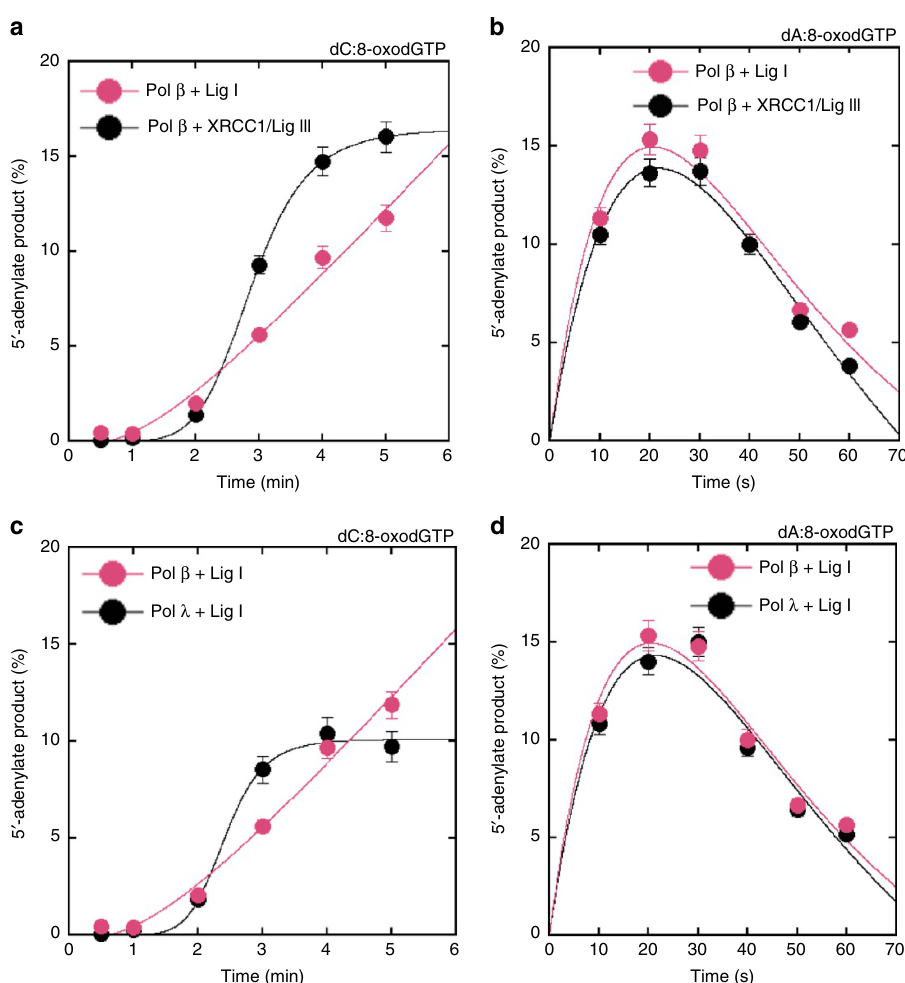
Figure 7 | Effect of XRCC1/Lig III and pol k on ligation failure. Plots show time-dependent changes in the products of 5’-adenylation for Lig I versus XRCC1/Lig III complex for the substrates C gap ( a ) and A gap ( b ) and for pol b versus pol l for the substrates C gap ( c ) and A gap ( d ). Time-dependent changes in ligation products are presented in Supplementary Fig. 7. The data represent mean values with the s.d. from three independent